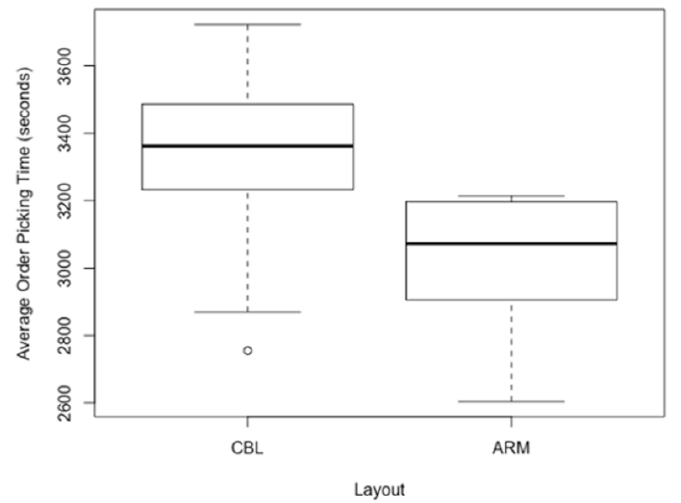
Figure 5. Comparison of class-based versus association rule mining (ARM)-based layouts for Scenario